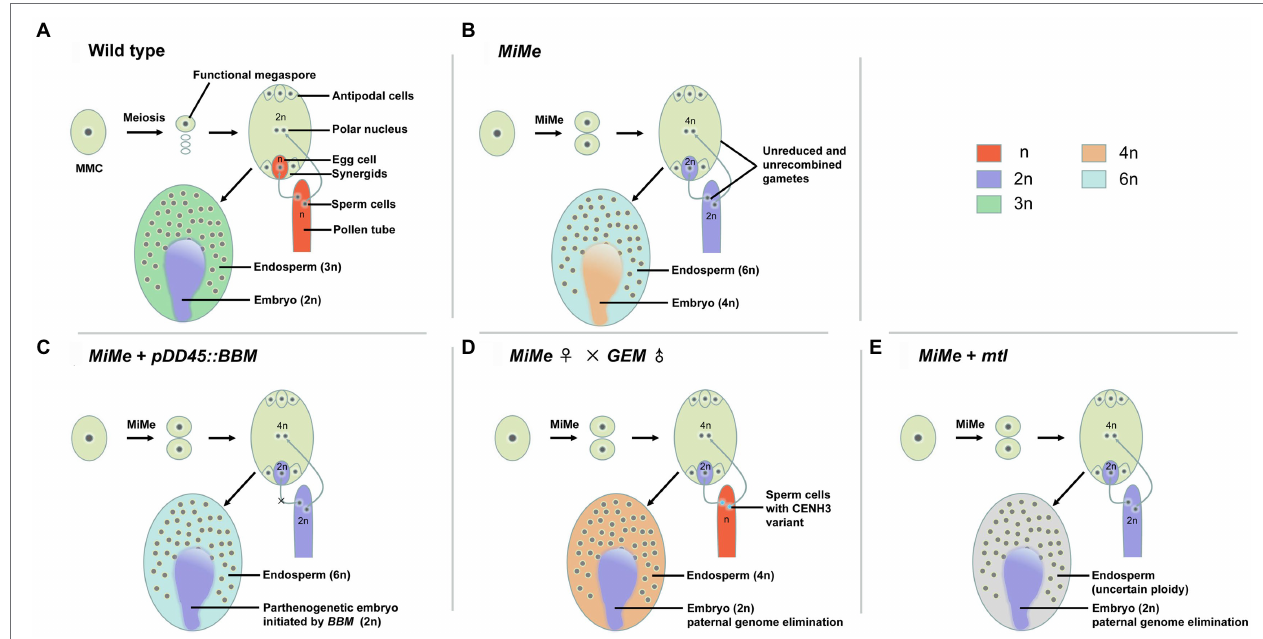
FIGURE 1 | Illustration of apomixis in wild type and engineering of asexual propagation through seeds based on the MiMe triple mutant. (A) In the wild type, the megaspore mother cell (MMC) undergoes meiosis, leading to the formation of reduced and recombined haploid (n) male and female gametes. Double fertilization of the egg cell and central cell by sperm cells leads to the formation of the embryo (2n) and endosperm (3n), respectively. (B) In the MiMe triple mutant, the MMC undergoes a mitotic-like division (mitosis instead of meiosis, MiMe), leading to the formation of unrecombined and unreduced diploid (2n) gametes. The fusion of the egg cell nucleus (2n) and central polar nucleus (4n) with the sperm cell nucleus (2n) produces a tetraploid (4n) clonal embryo and hexaploid (6n) endosperm, respectively. (C–E) Engineering apomixis has been achieved using three schemes based on the MiMe triple mutant. (C) Combination of the MiMe triple mutant with the ectopic expression of BBM ( OsBBM1 in rice) in the egg cell triggers the formation of a parthenogenetic embryo (2n). (D) Crossing the male CENH3-modified genome elimination line ( GEM ) with the female MiMe triple mutant triggers the formation of a diploid clonal embryo (2n). (E) Creating the MiMe mtl quadruple mutant triggers the formation of a diploid clonal embryo (2n), but the ploidy of the endosperm is not